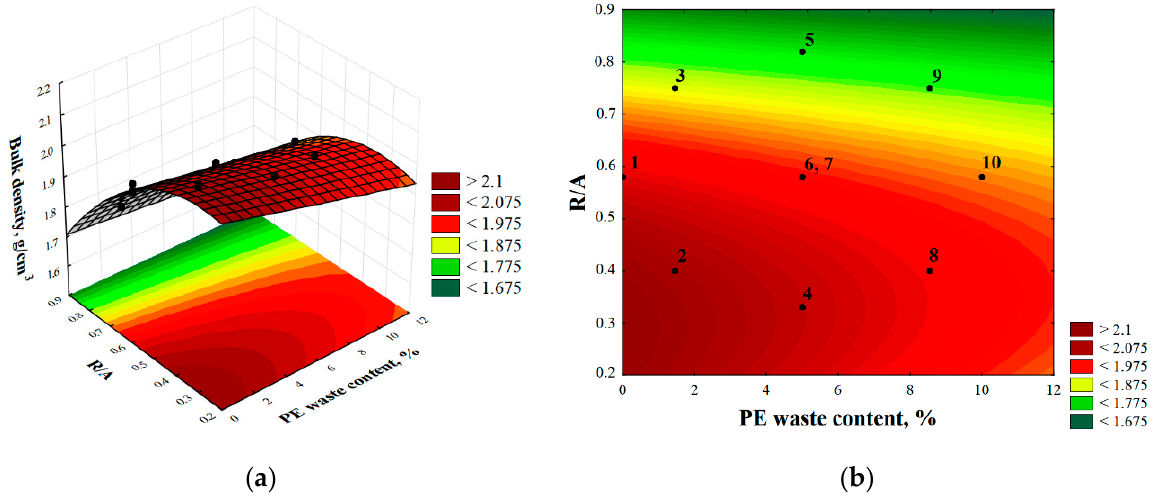
Figure 16. Three-dimensional ( a ) and contour ( b ) plot of response surface for bulk density. The volumetric density values ranged from 1.79 g/cm 3 to 2.08 g/cm 3 . The